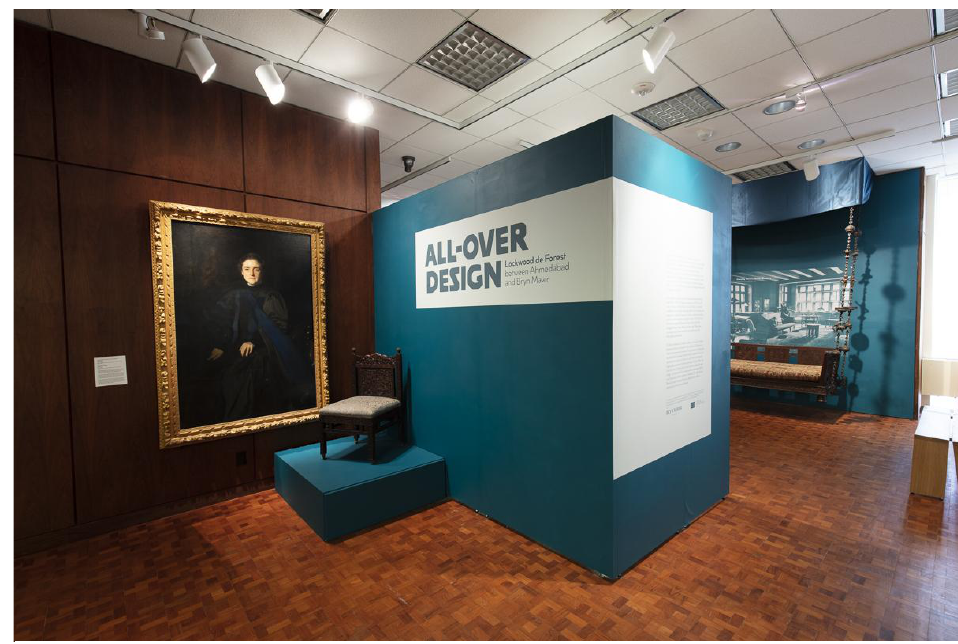
Installation shot of “All-Over Design”: Lockwood de Forest between Ahmedabad and Bryn Mawr. (Photograph by Zachary Hartzell, courtesy Bryn Mawr College Special Collections.)